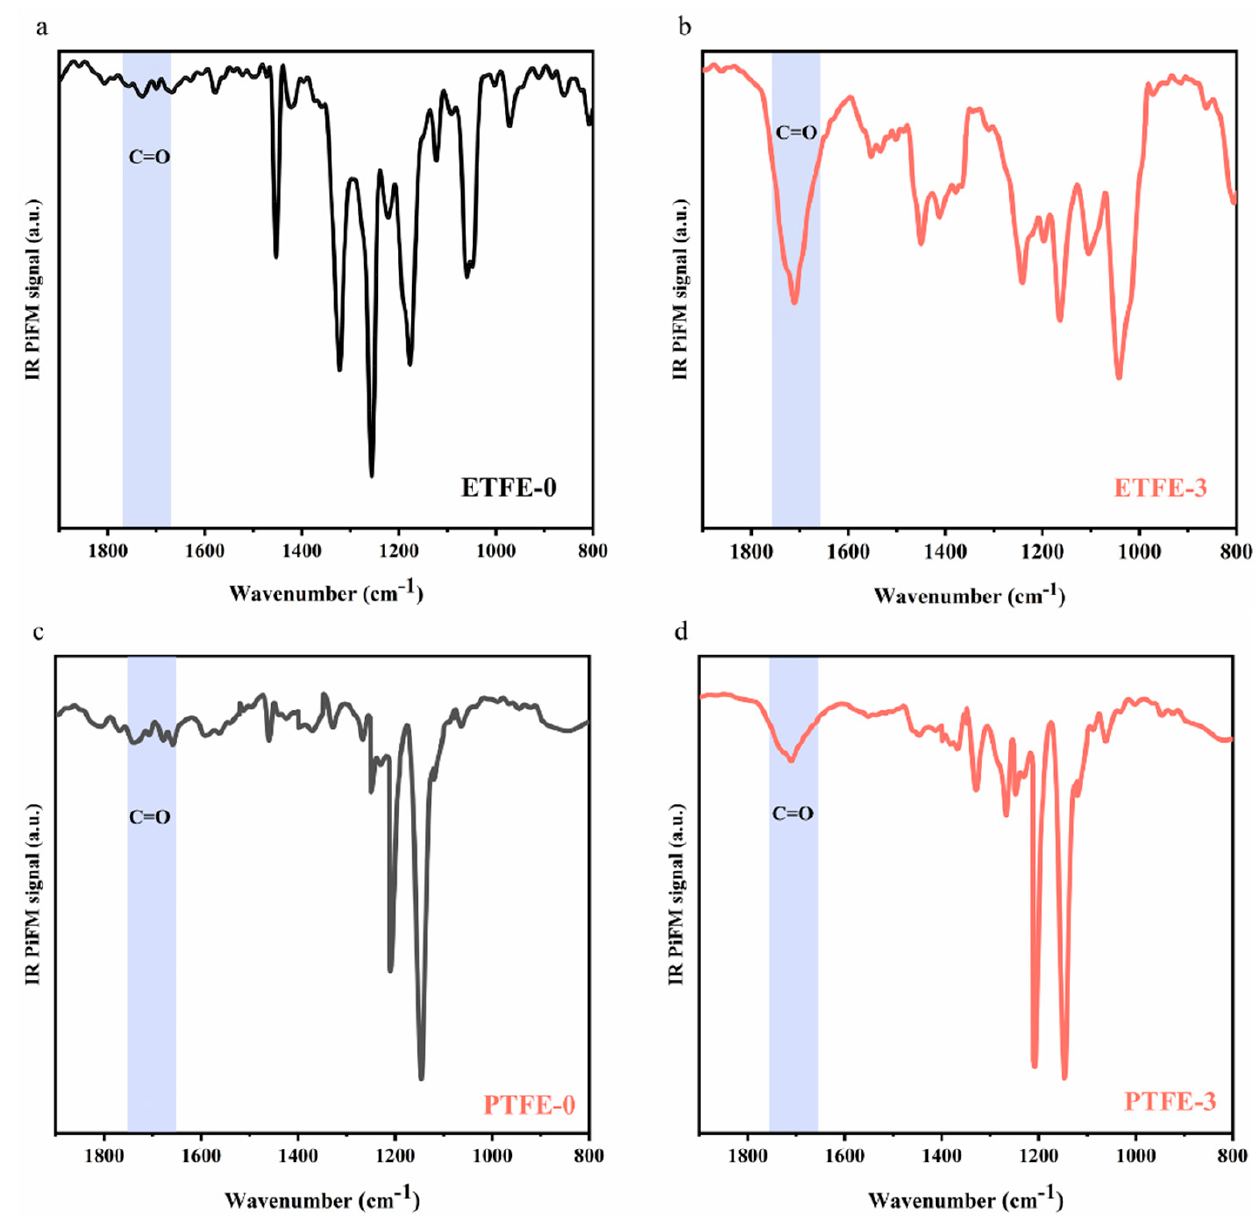
Figure 4. Comparison of IR PiFM spectra of membrane surface before and after treatment: ( a ) ETFE-0 membrane, ( b ) ETFE-3 membrane, ( c ) PTFE-0 membrane, and ( d ) PTFE-3 membrane.